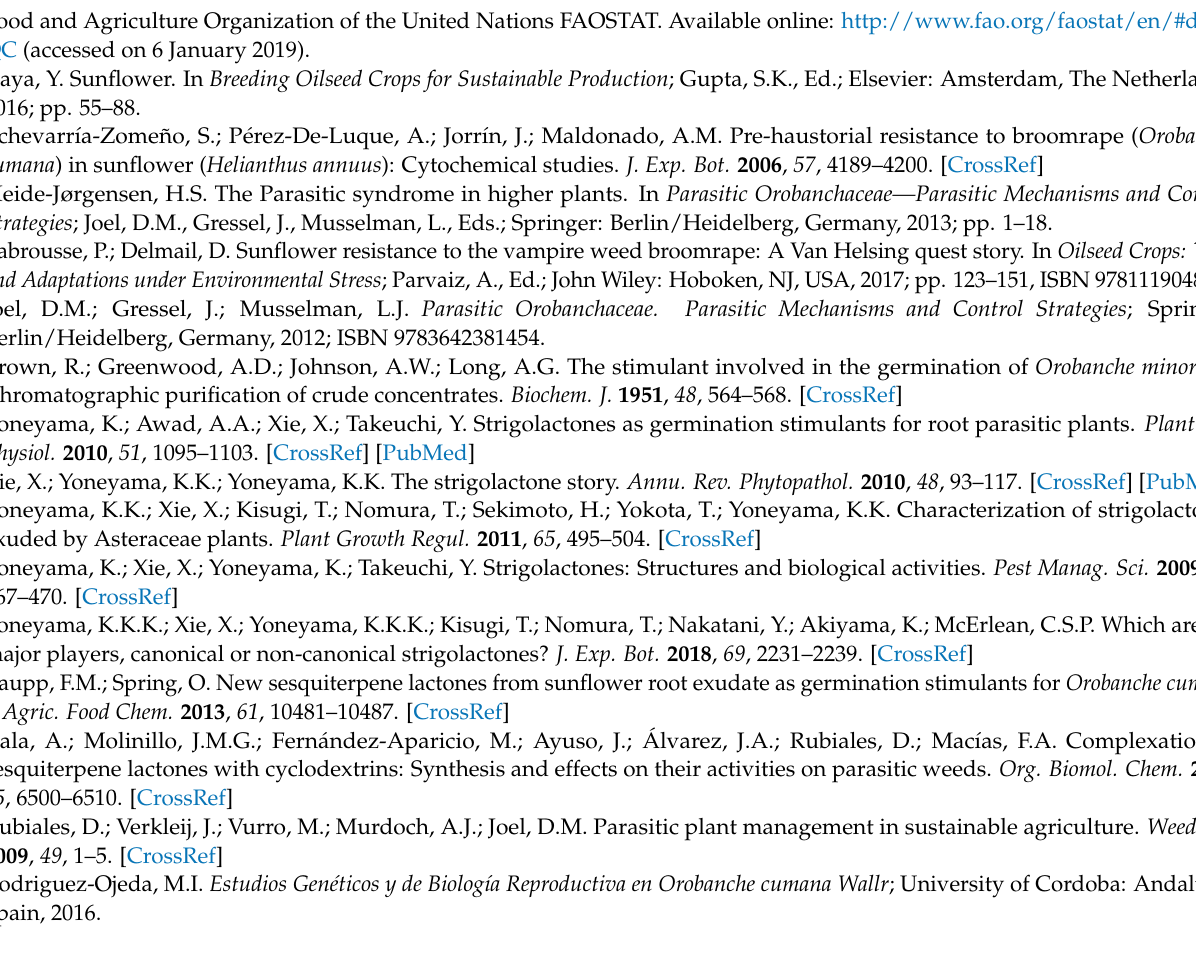
Table S2: Analytical characteristics of the chromatographic